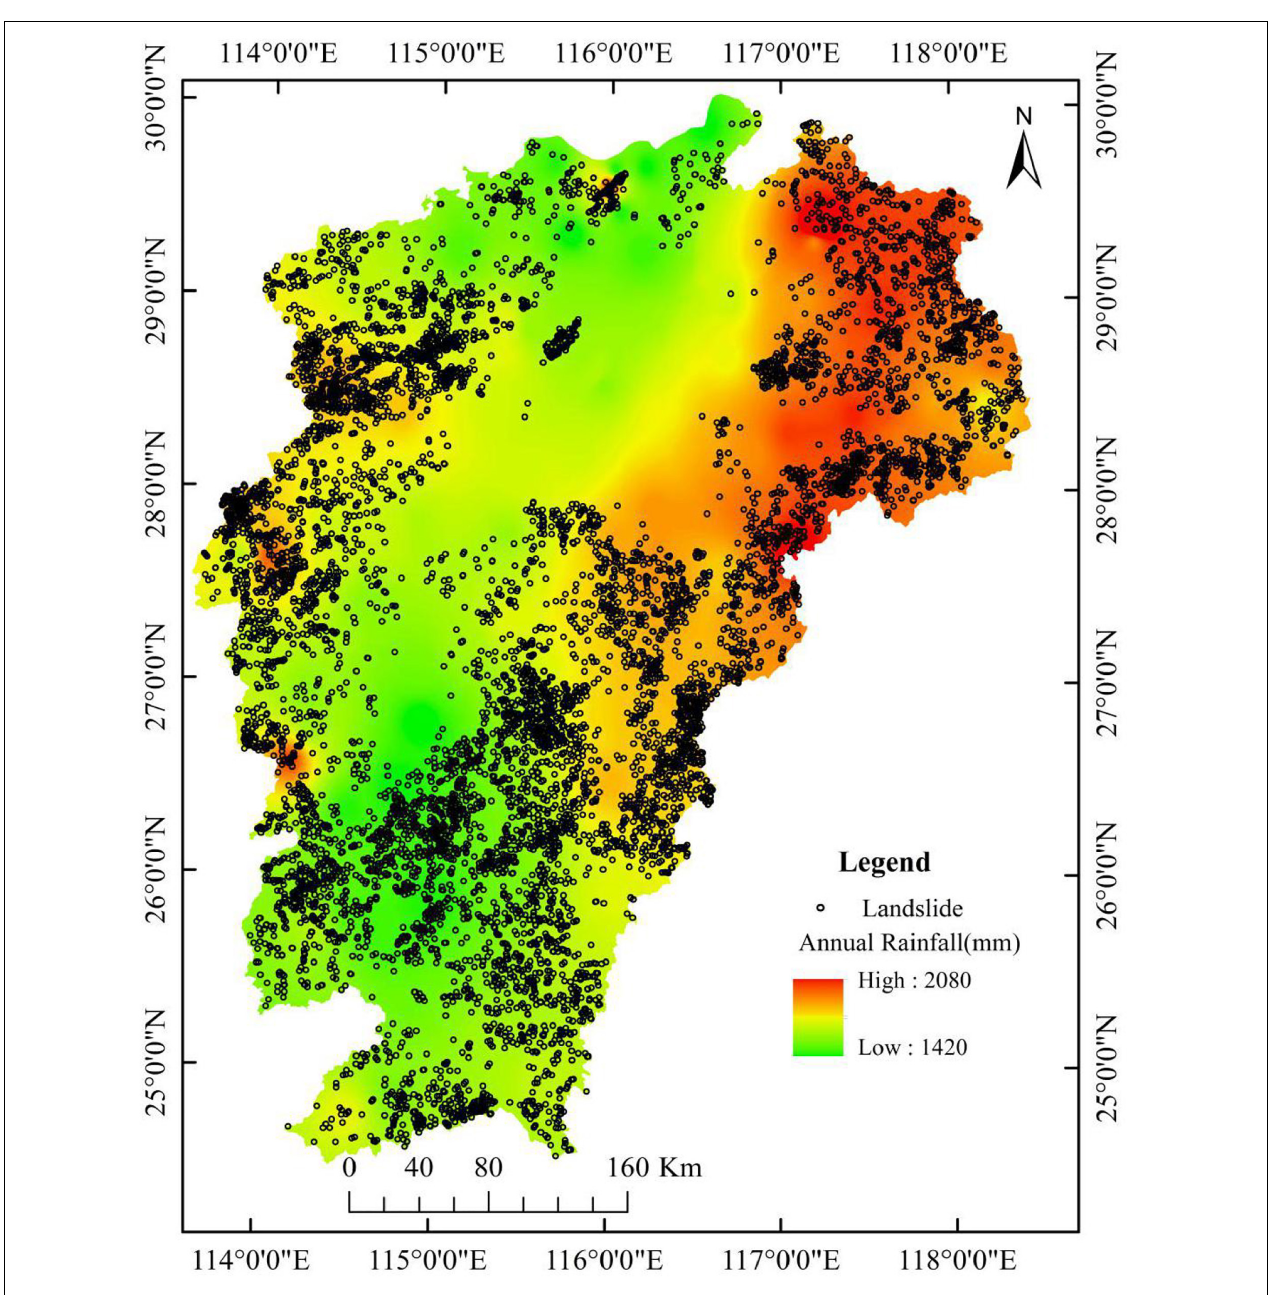
FIGURE 2 | Distribution map of landslide in Jiangxi in the context of annual